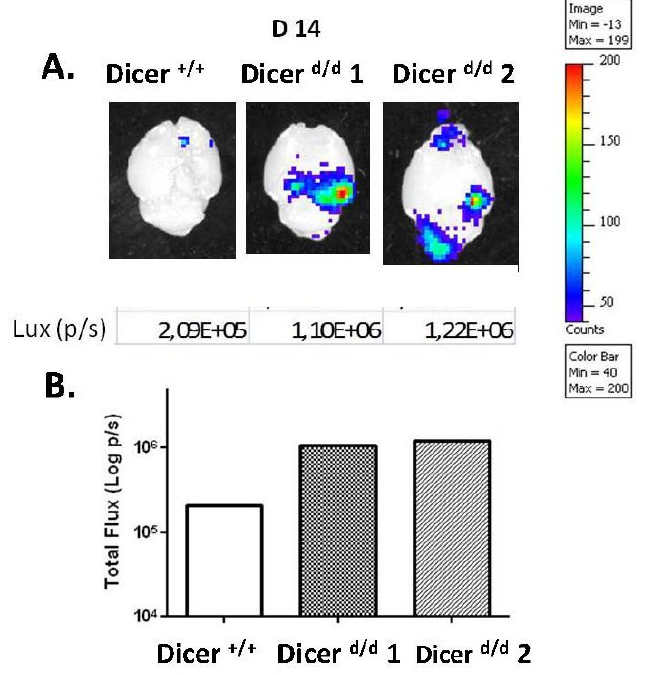
Figure 4. Increased brain infection in Dicer d/d mutants. ( A ). Snapshot image illustrating luminescence from the dissected brains harvested in a representative control neonate (Dicer +/+ ) and two Dicer d/d mutants. ( B ). Luminescence (expressed in photons/sec or p/s) was quantified and plotted for each brain.